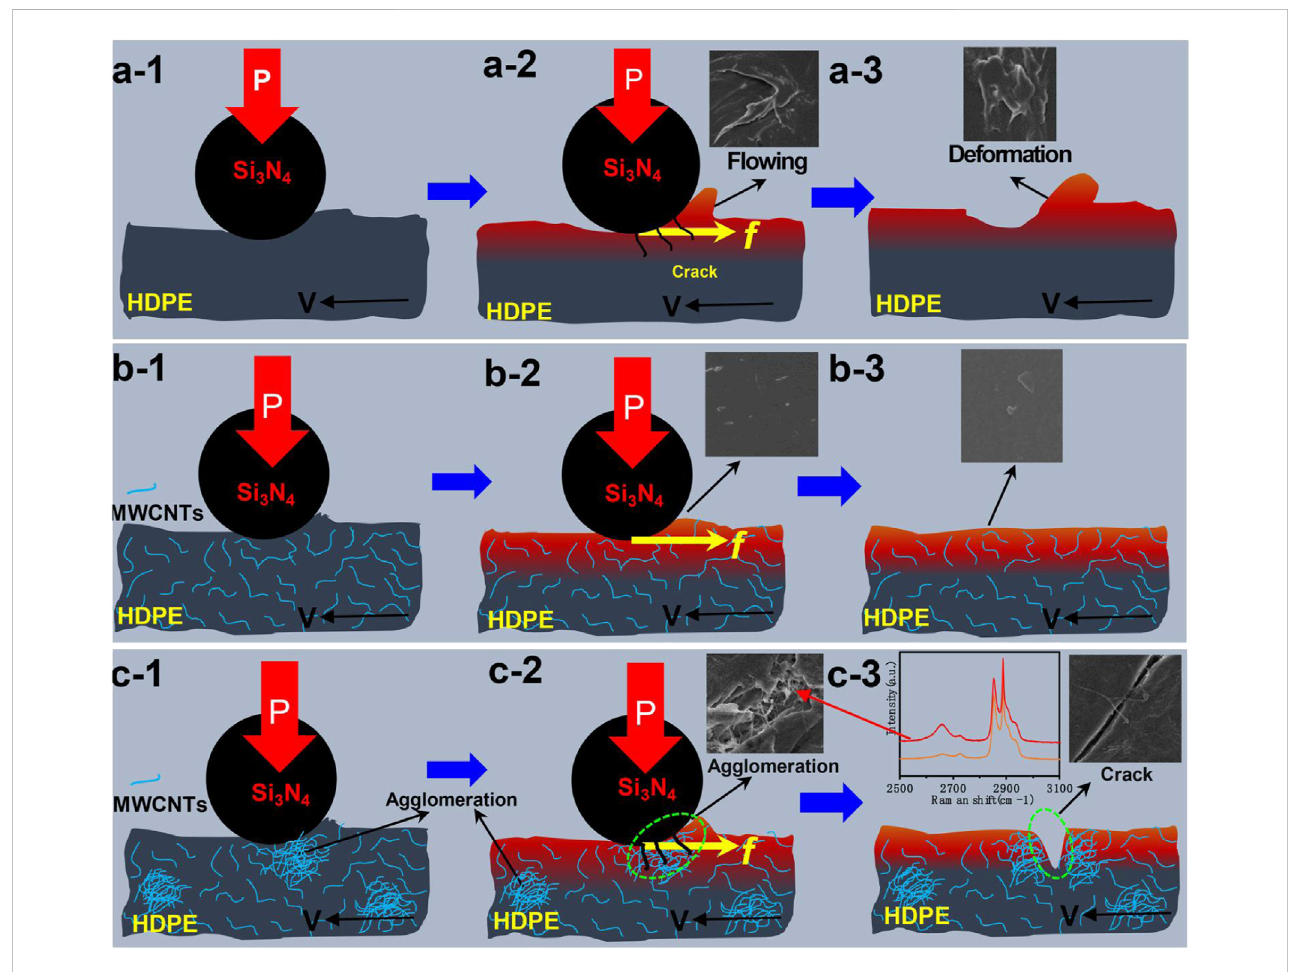
FIGURE 1 Friction reduction models of HDPE (a-1, a-2, a-3), HDPE with moderate 5p [6-xujyhof MWCNTs (b-1, b-2, b-3), and excess MWCNTs (c-1, c-2, c-3) (Wu et al., 2021).